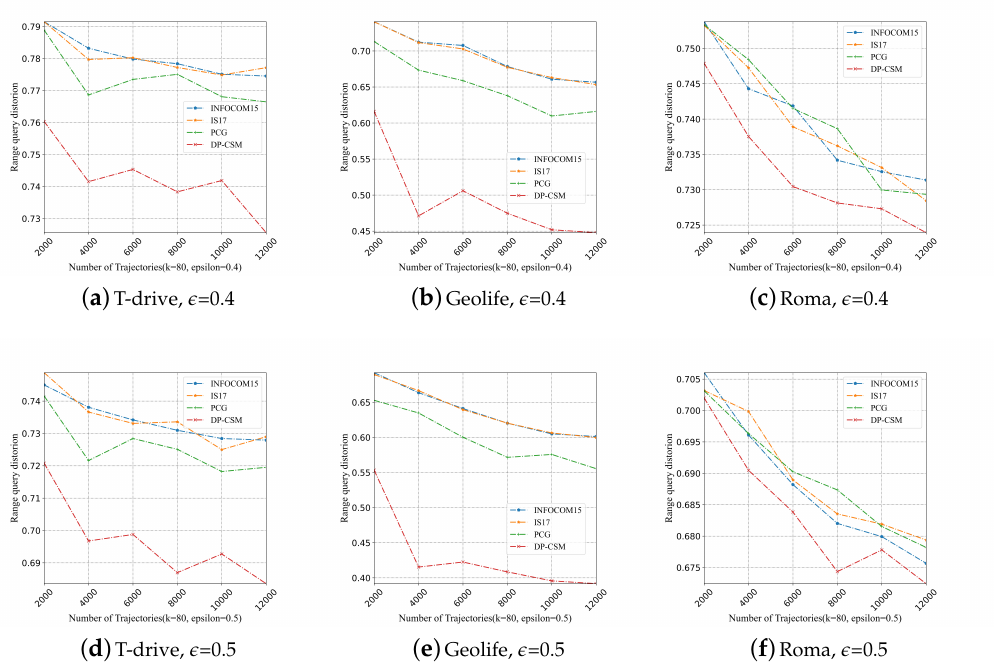
Figure 6. Range query distortion comparison of the four models under different settings. In particular, we fix k = 80 and vary the privacy budget (cid:101) and the size of trajectory datasets. For the privacy budget, we choose two kinds of values, i.e., (cid:101) = 0.4 and (cid:101) = 0.5, respectively. Under each privacy budget, we vary the sizes of trajectory